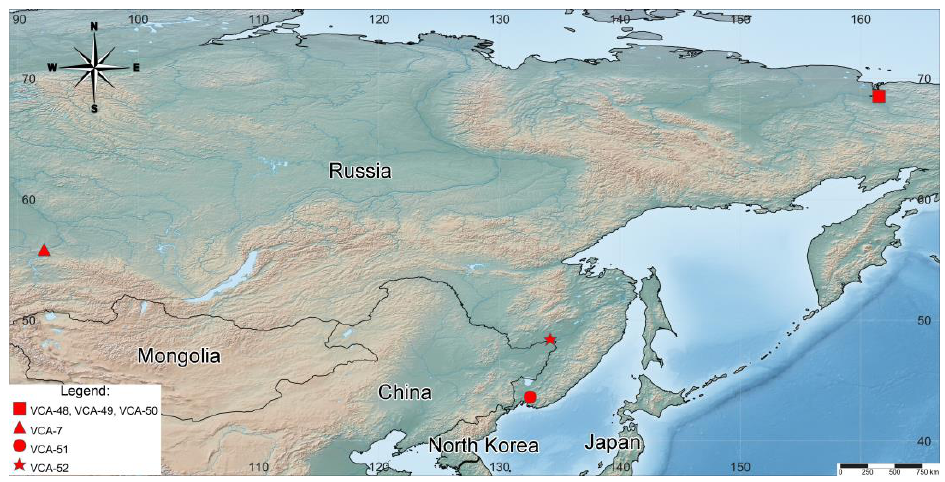
Figure 1. Map of sample sites. See the legend for details.